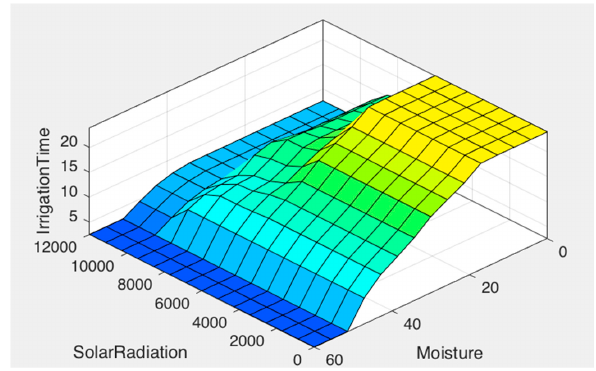
Figure 15. Relation between solar radiation and moisture.